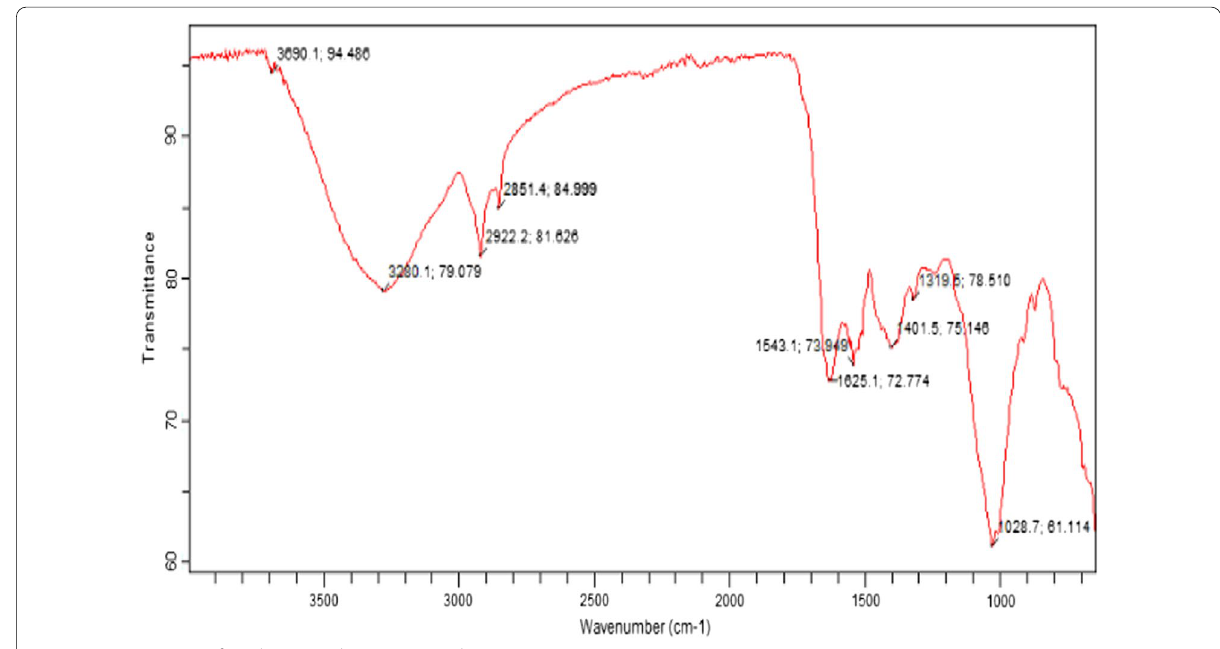
Fig. 1 FTIR spectrum of M. charantia silver